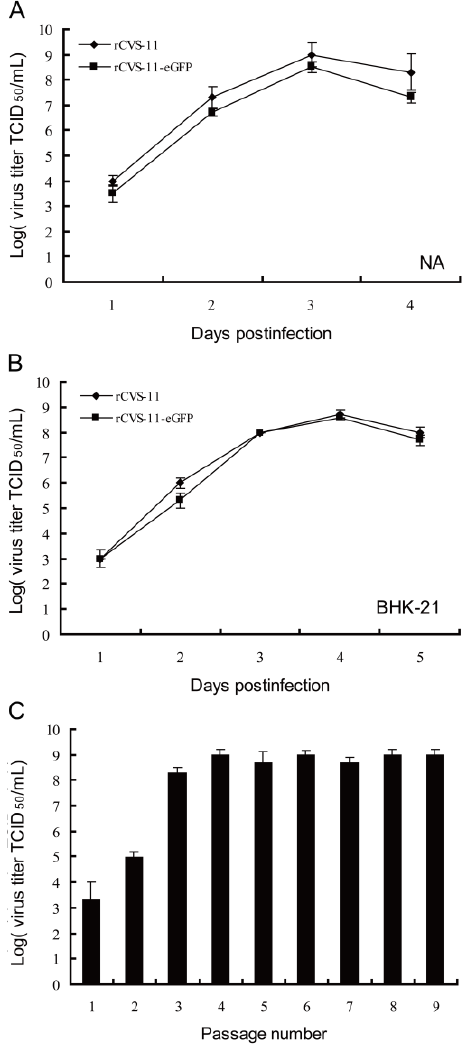
Figure 3. Growth characteristics of the rCVS-11 and rCVS-11-eGFP strains in NA and BHK-21 cells. ( A , B ) NA and BHK-21 cells were infected with rCVS-11 and rCVS-11-eGFP at an MOI of 0.1, and the viruses were titrated at different day p.i. The results are the means ± standard error of the mean (SEM) from titers in triplicate per day p.i. ( p > 0.05); ( C ) Viral serial passage in BHK-21 cells. BHK-21 cells were infected with the rCVS-11-eGFP strain at an MOI of 0.1, and the supernatants from each passage were harvested at 96 h p.i.; the viral titers were determined in triplicate ( p > 0.05). The values shown are the means ±